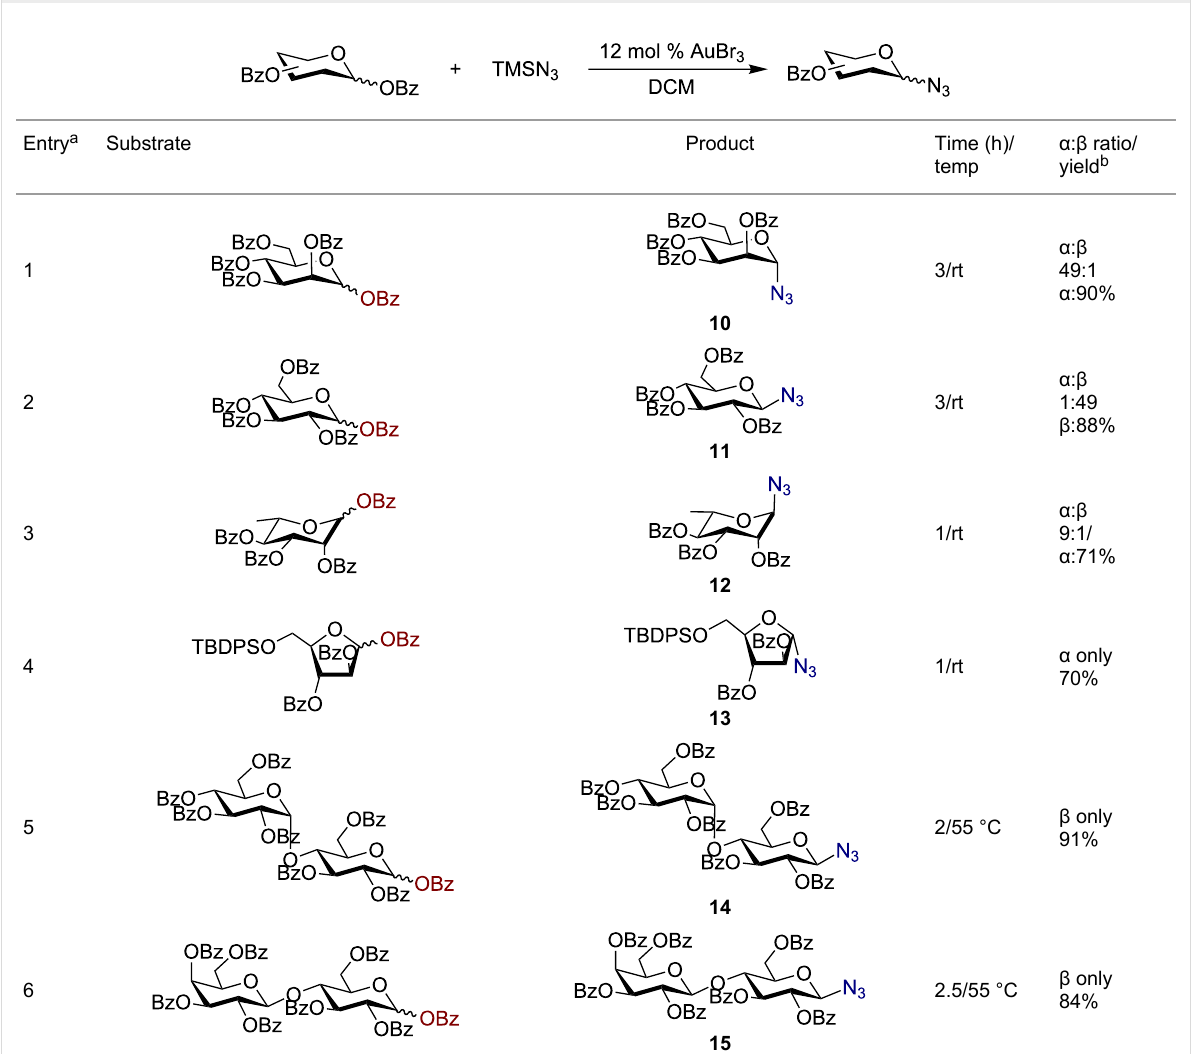
Table 2: Scope of AuBr 3 -catalyzed azido glycosylation of perbenzoylated sugars.